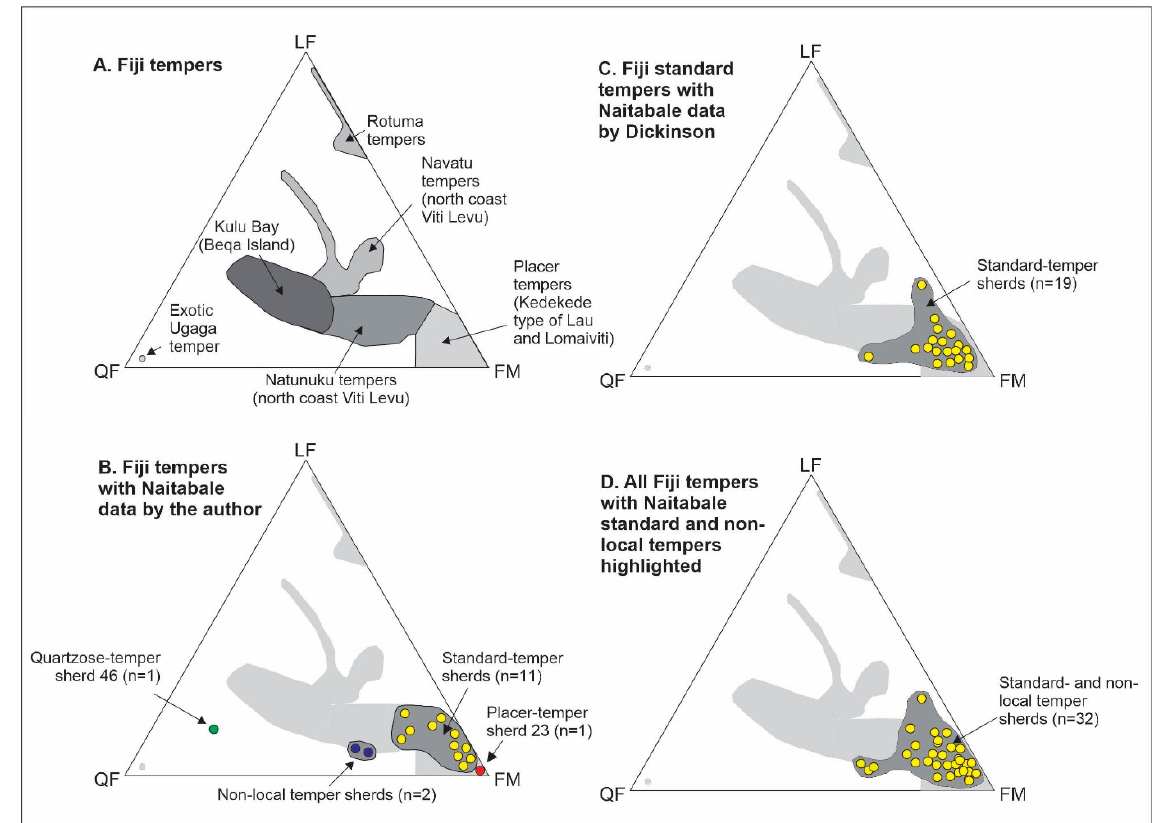
Figure 4. Ternary diagrams showing the LF-QF-FM values for all Fiji sherd tempers. ( A )—Characterization of Fiji temper types. ( B )—Naitabale sherd tempers analyzed by Kumar. ( C )—Naitabale sherd tempers analyzed by Dickinson. ( D )— Naitabale tempers. Table 1. Mineralogical analyses of sand tempers in 15 Lapita potsherds from Naitabale by Roselyn Kumar reported in this study. Mineral percentages and raw counts (in brackets) are given. Motifs classified according to the system of Anson [24] .